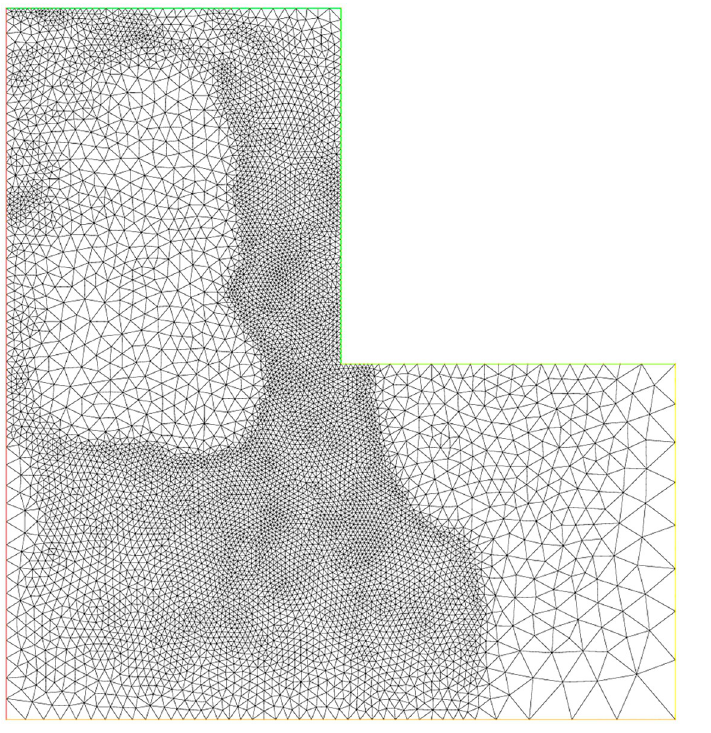
Fig 11. Adaptive mesh refinement with 13804 nodes for the L-shaped domain.